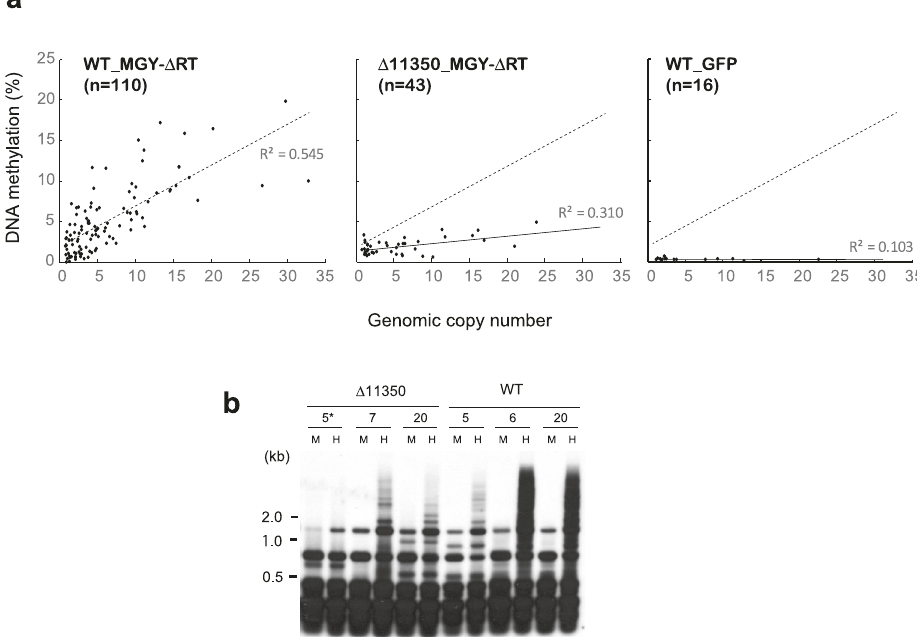
Fig. 1 Relation between the copy number in the genome and degree of MAGGY DNA methylation in Pyricularia oryzae . a A transposition-de fi cient MAGGY mutant, MGY- Δ RT was introduced into a MAGGY-free P. oryzae strain, Br48 (WT) and a double deletion mutant of Rhm51 and MGG_15577 ( Δ 11350). The integrated copy numbers and the rates of DNA methylation of MGY- Δ RT were assessed by qPCR and qMSRE methods with a HapI I (CCGG) restriction enzyme, respectively. As a control, pEGFP75 carrying the EGFP gene driven by the Aspergillus nidulans TrpC promoter was introduced into Br48 (WT_GFP). The dashed line represents the regression line in WT_MGY- Δ RT. b Southern blot analysis of DNA methylation of MGY- Δ RT. Three transformants having different integrated copy numbers of MGY- Δ RT were picked up from WT and Δ 11350, respectively, and subjected to Southern blot analysis using methylation-insensitive Msp I (M) and -sensitive Hap II (H) restriction enzymes. *, the integrated copy number of MGY- Δ RT.